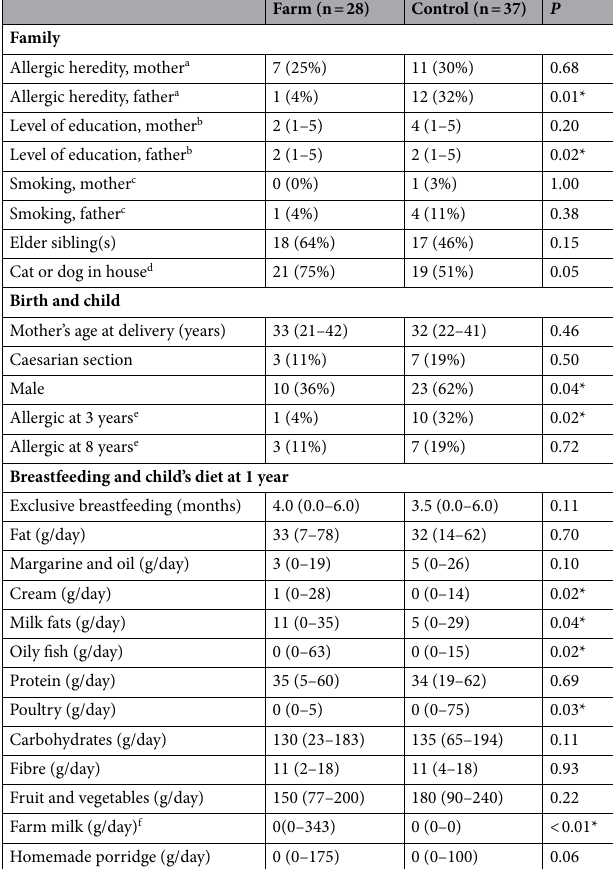
Table 1. General and nutritional characteristics of farm and control children. Data are n (%) or median (range). * P < 0.05, Chi-squared or Fisher’s exact test for counts, Mann–Whitney U-test for continuous variables. a Doctor-diagnosed asthma, rhinitis, or atopic eczema. b 1 = Elementary school, 2 = upper